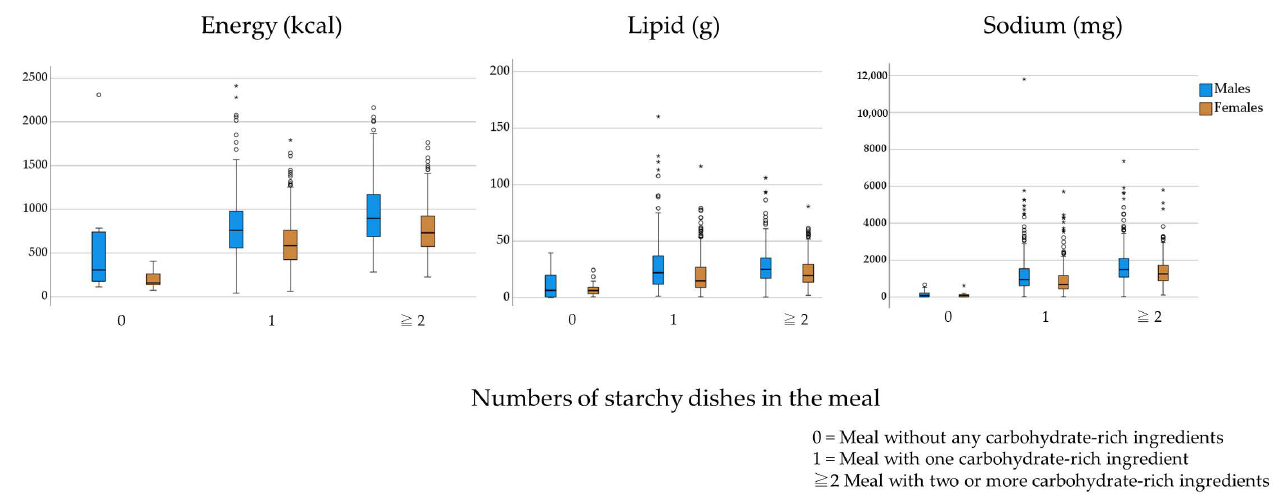
Figure 2. Differences between meal types in energy, sodium, and lipid quantities. Interquartile range (IQR) means from 25th to 75th percentile drawn as the length of the boxes. The upper whiskers represent adjacent values that are not more than 75th percentile + 1.5 × IQR, and the lower whiskers represent adjacent values that are not less than 25th percentile – 1.5 IQR. Stars represent extreme values (larger than 75th percentile + 3.0 × IQR or smaller than 25th percentile – 3.0 × IQR). White circles represent outliers: outside of whiskers, but not extreme